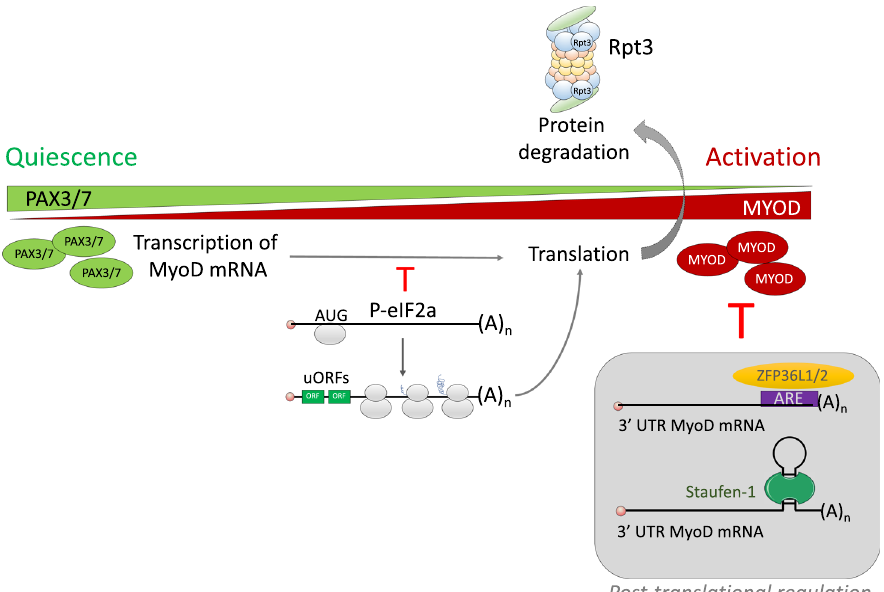
Fig. 2 Transcriptional regulation controls MuSC quiescence. While MuSC quiescence is primarily associated with PAX3/7 expression, MYF5 and MYOD are hallmarks of MuSC activation and myogenic commitment. Myf5/MyoD transcripts are expressed in quiescent MuSCs, but they are sequestered in messenger ribonucleoprotein (mRNP) granules. Such granules contain RNA-binding proteins like ZFP36 and Staufen-1, which act in granule assembly and mRNA sequestration, respectively. Dissociation from the mRNP granules and translation initiation is mediated by phosphorylation of the eIF2a protein. Color code of quiescence-to-activation trajectory: green, quiescence; red,